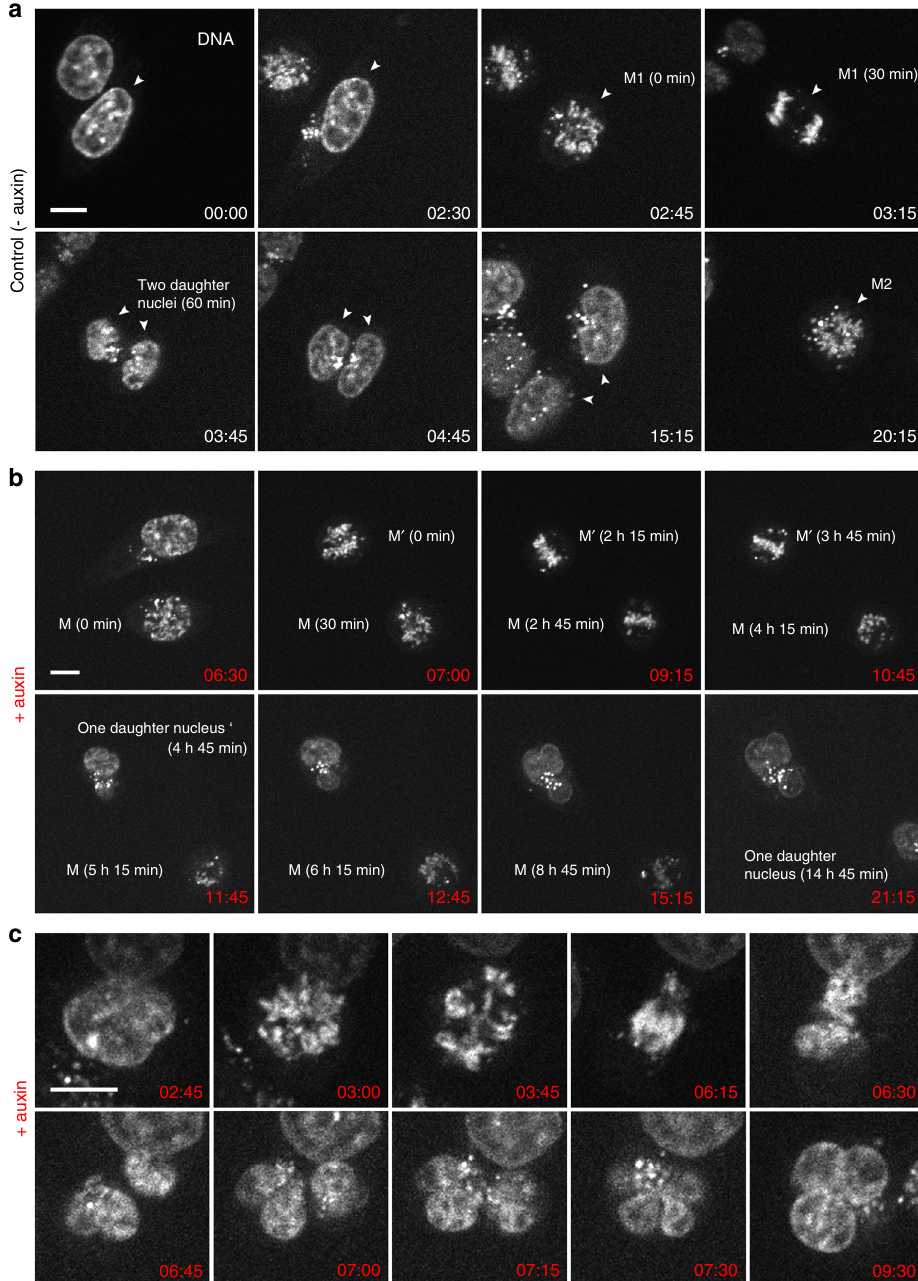
Fig. 1 Live-cell microscopy demonstrating prolonged abnormal mitosis with subsequent formation of one endomitotic multilobulated nucleus (MLN) in cohesin depleted cells. a Selected points from time-lapse imaging ( Σ t = 21 h, Δ t = 15 min) of untreated control cells ( − auxin) with the accomplishment of mitosis (M1) with in 1h (time 02:45 – 03:45) and subsequent formation of two daughter nuclei. DNA stained with SiR-DNA. A second mitosis (M2) of one daughter nucleus is shown at time 20:15. b Selected time lapse images of nuclei after cohesin degradation ( + auxin) conducted in parallel to control cells demonstrate a prolonged mitotic stage. Mitosis (M) emerges at time 6:30 after auxin treatment, transition into one abnormal multilobulated daughter nucleus (MLN) is seen 14:45 h later (time 21:15). Mitosis (M ’ ) emerges 7 h after auxin treatment (time 07:00), transition into an MLN is seen 4:45 h later (time 11:45). c Time-lapse imaging from the same series at a higher zoom shows an aberrant mitosis with an adumbrated formation of two daughter nuclei (time 06:45), that fi nally appear as one MLN at time 7:15. Scale bar: 10 µ m. M, M1, M2, M ’ denote different mitoses. Images shown in a – c show representative nuclei from one of three independent